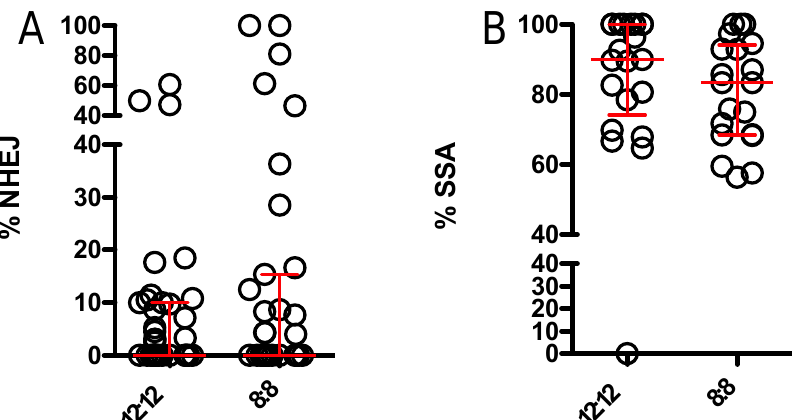
Figure 4. Relative usage of NHEJ and SSA DSB repair pathways with maternal effect endonuclease